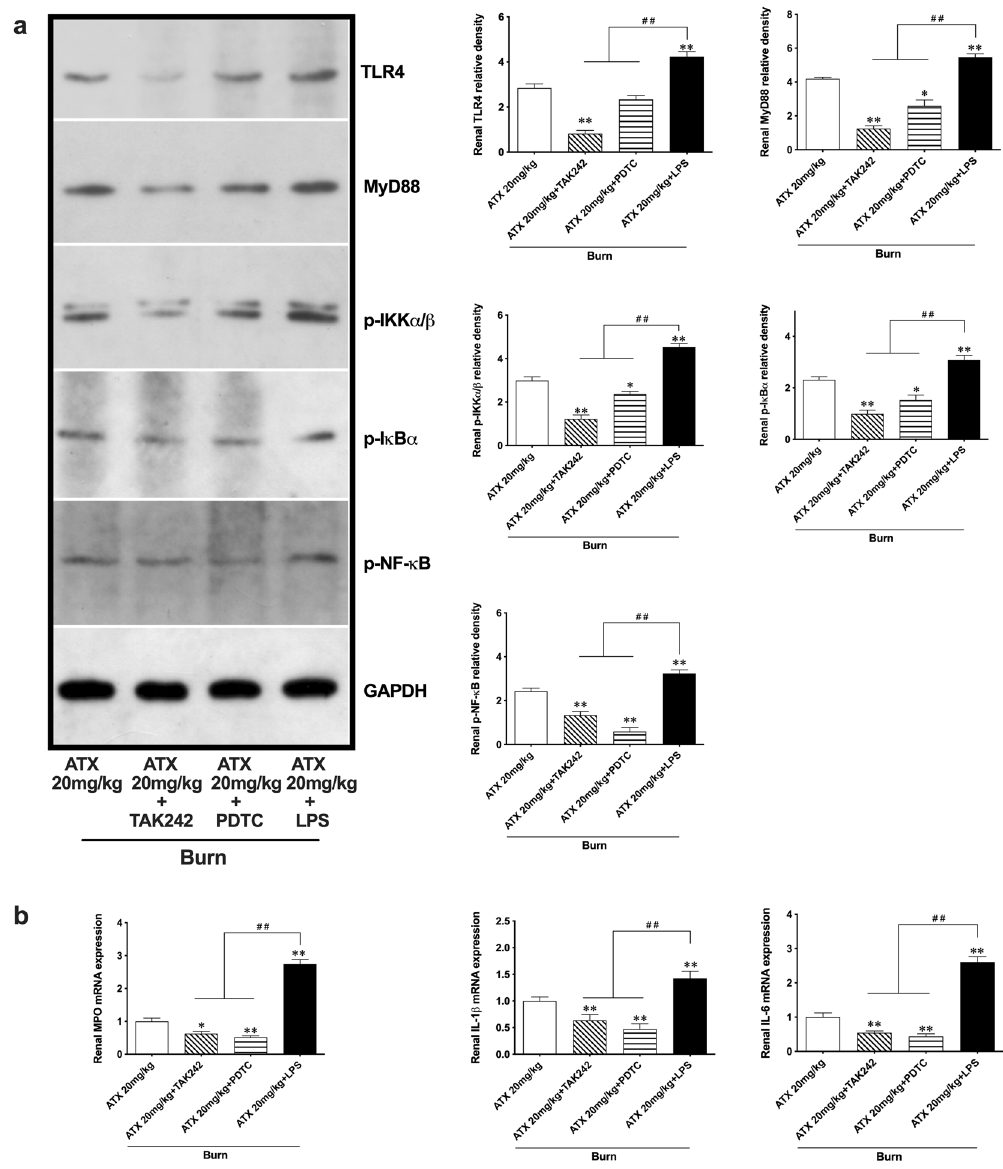
Figure 6. Astaxanthin attenuates burn-induced inflammation through regulating TLR4 /MyD88/NF-κB pathway. ( a ) Representative bands of western blot are shown after introduction of LPS, TAK242 and PDTC. LPS reversed the effect of high-dose ATX on expression of TLR4, MyD88 and downstream phosphorylated activation of IKKα/β, Iκ, BαNF-κB, while both TAK242 and PDTC could help to enhance the effect of ATX; ( b ) The inhibition of ATX on release of selected inflammatory mediators could be abolished by LPS, and enhanceb by using TAK242 or PDTC. n = 6 for each group. The results are expressed as the mean ± SD. * p < 0.05, ** p < 0.01, v.s. ATX 20 mg/kg; # p < 0.05, ## p <